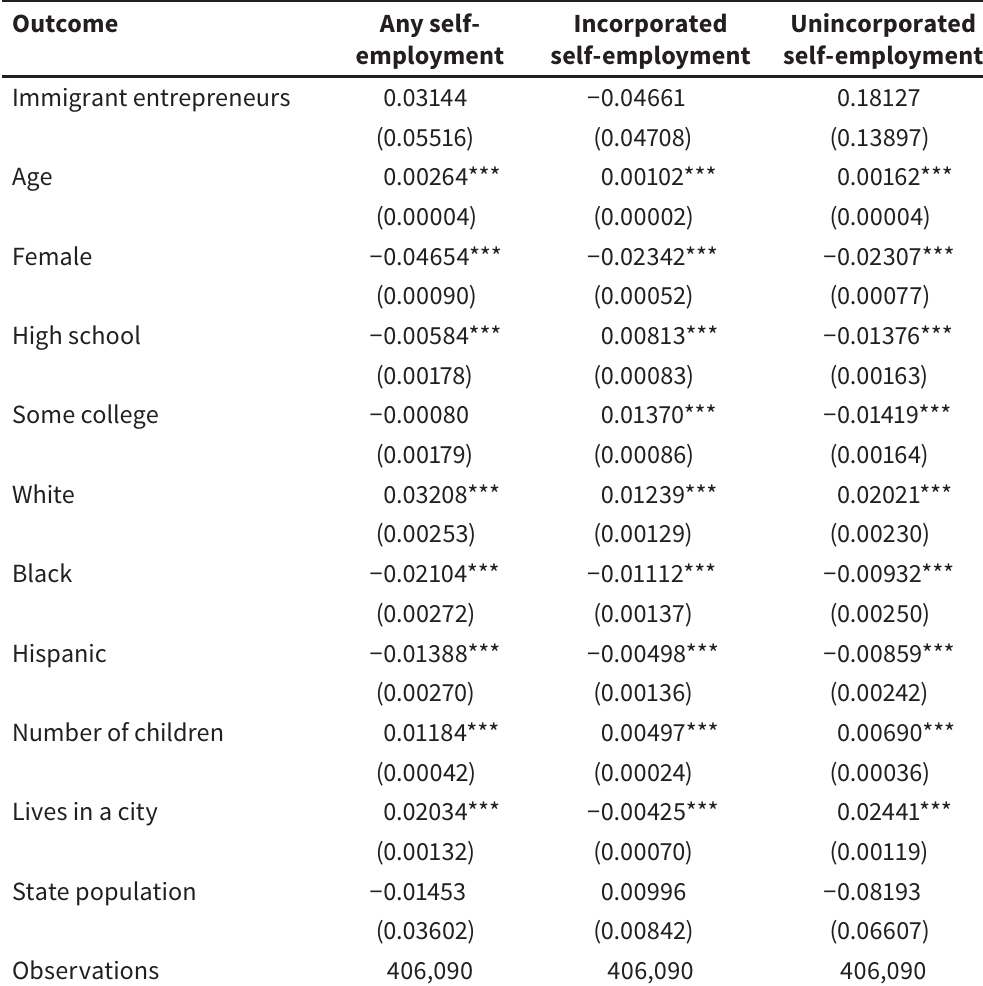
Heterogeneity in the Impact of Immigrant Entrepreneurs across Skill Levels of Natives: Second Stage Estimates for Low